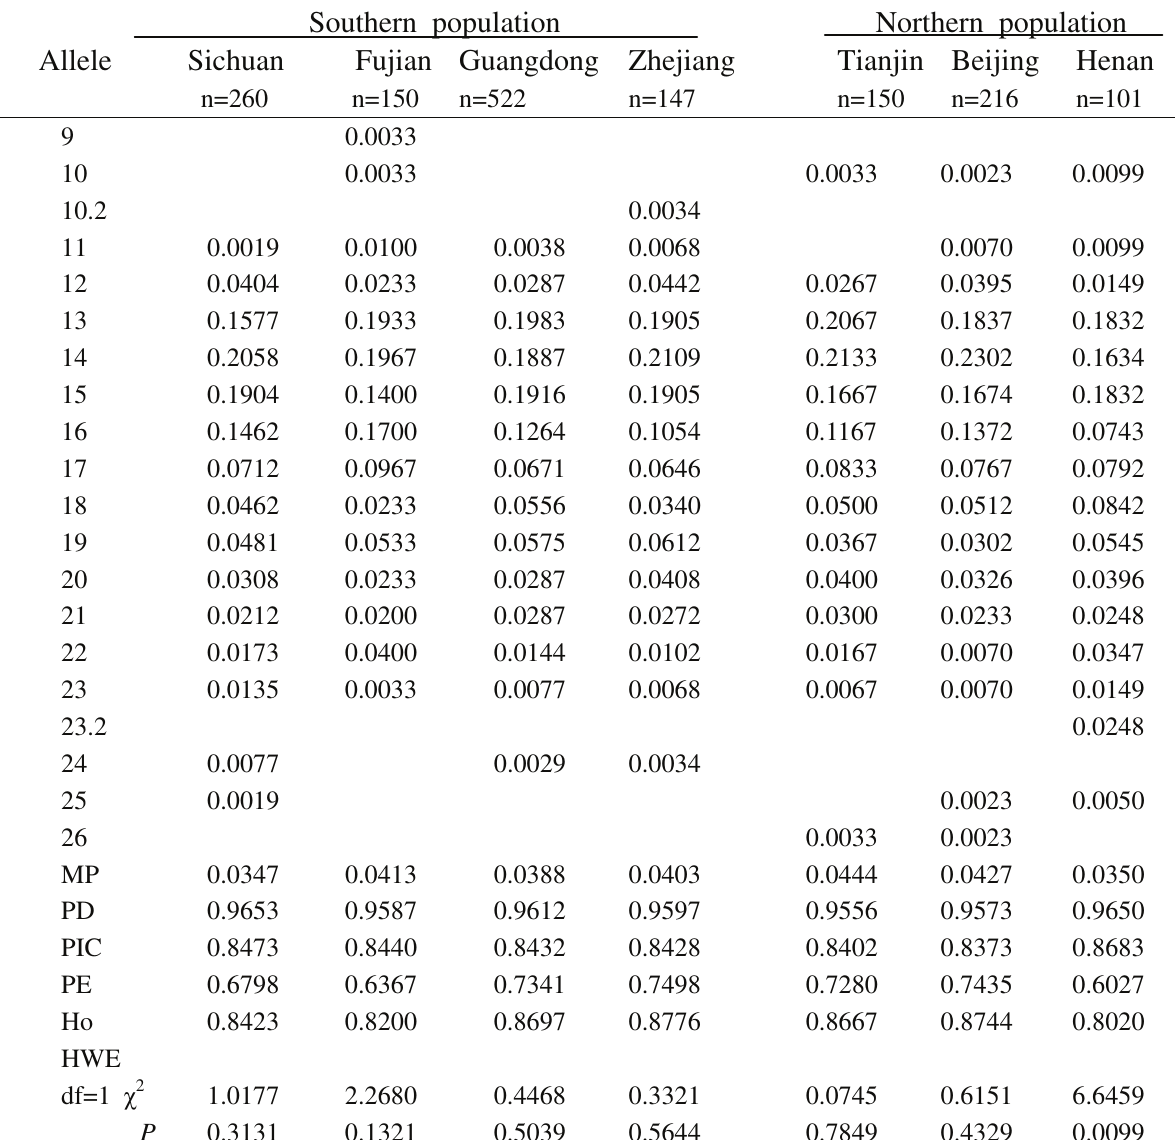
Table S11- Genetic polymorphism at the D18S51 locus for the seven Chinese population